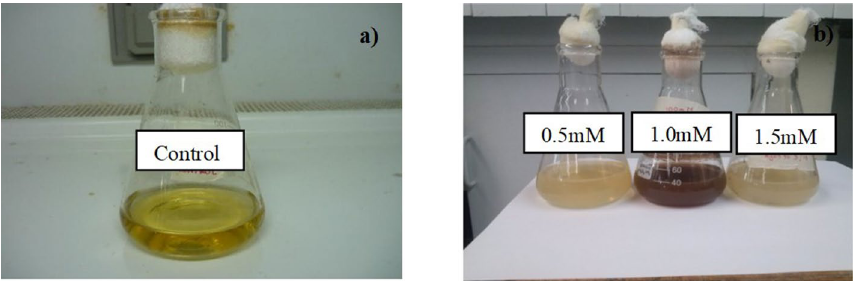
Figure 1. AgNPs biosynthesis in the CS sample ( a ) Control sample of the fungal filtrate of the fungus anamorphous Bjerkandera sp. R1; ( b ) Formation of silver nanoparticles after 48 h of incubation for different AgNO 3 concentrations in the synthesis of